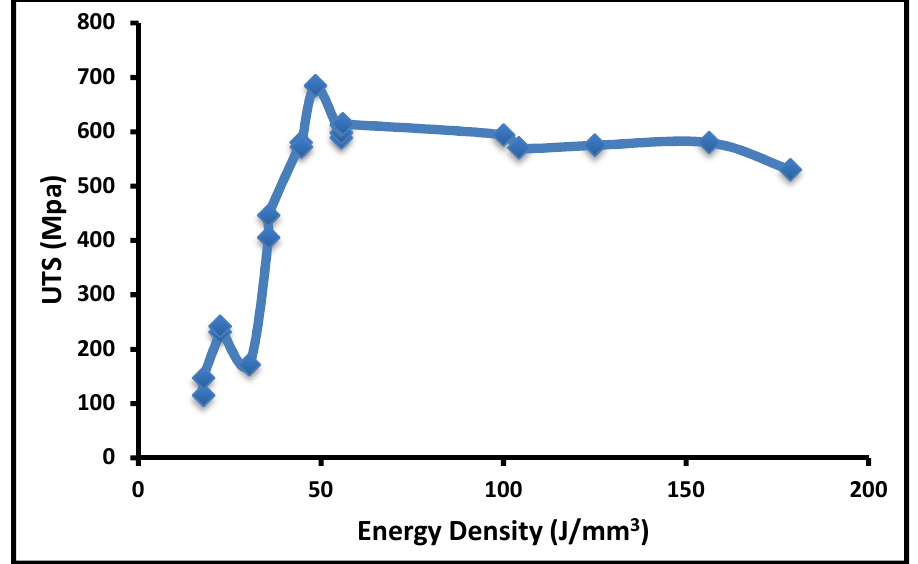
Figure 3. Tensile strength at a different energy density.